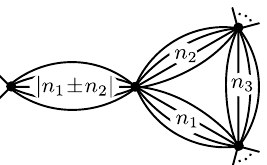
Figure 17: A triangle is trivial if two of its internal bubbles, with n connected to an external bubble with | n